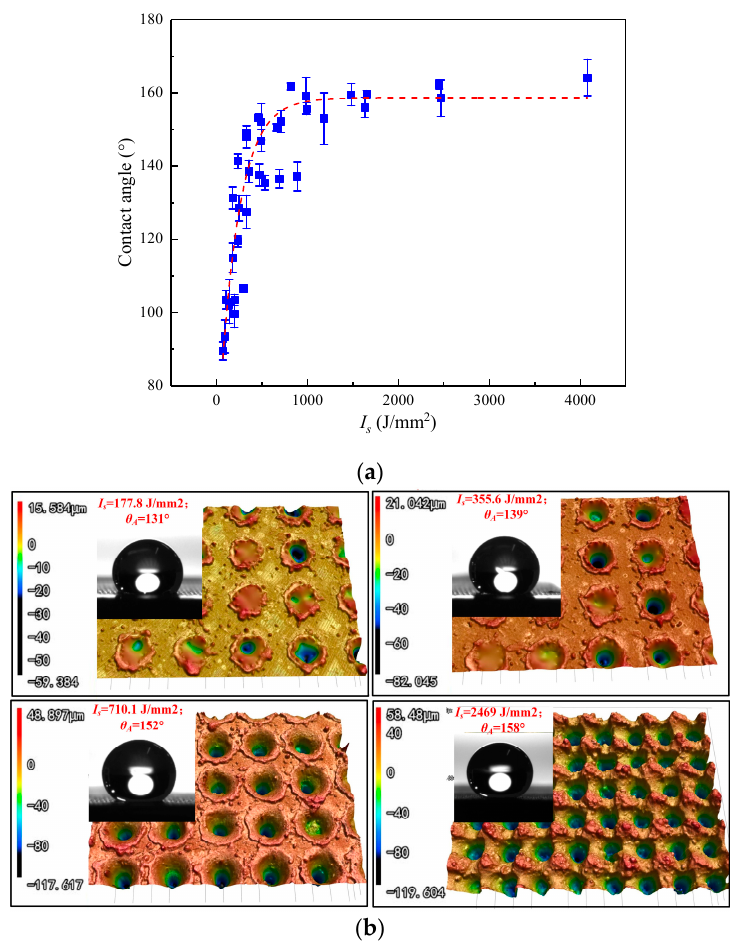
Figure 11. ( a ) Scatter plot and fitted curve between contact angle and I s ; ( b ) Surface morphology and shape of water drops on specimens with a different value of I s .